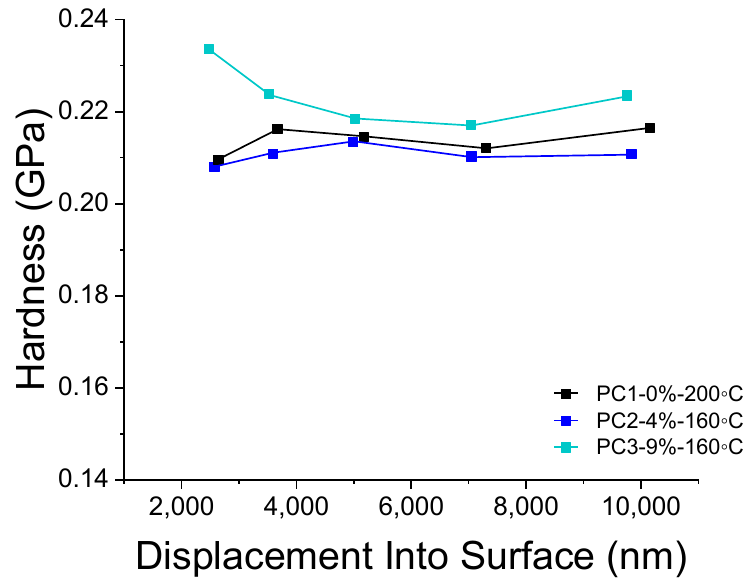
Figure 8. DSI results comparing hardness of PC1 cured at 200 °C and PC2 and PC3 cured at 160